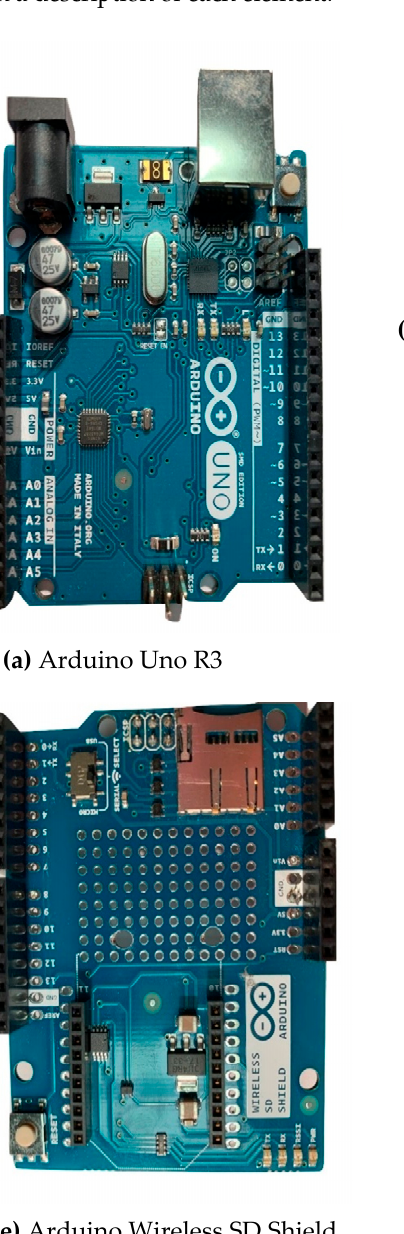
Figure 2. Components of the Arduino-based LEWIS2: ( a ) Arduino Uno R3, ( b ) MPU9250 breakout board, ( c ) XBee Series 1 Module, ( d ) Secure Digital (SD) Card, ( e ) Arduino Wireless SD Shield, ( f ) Battery.